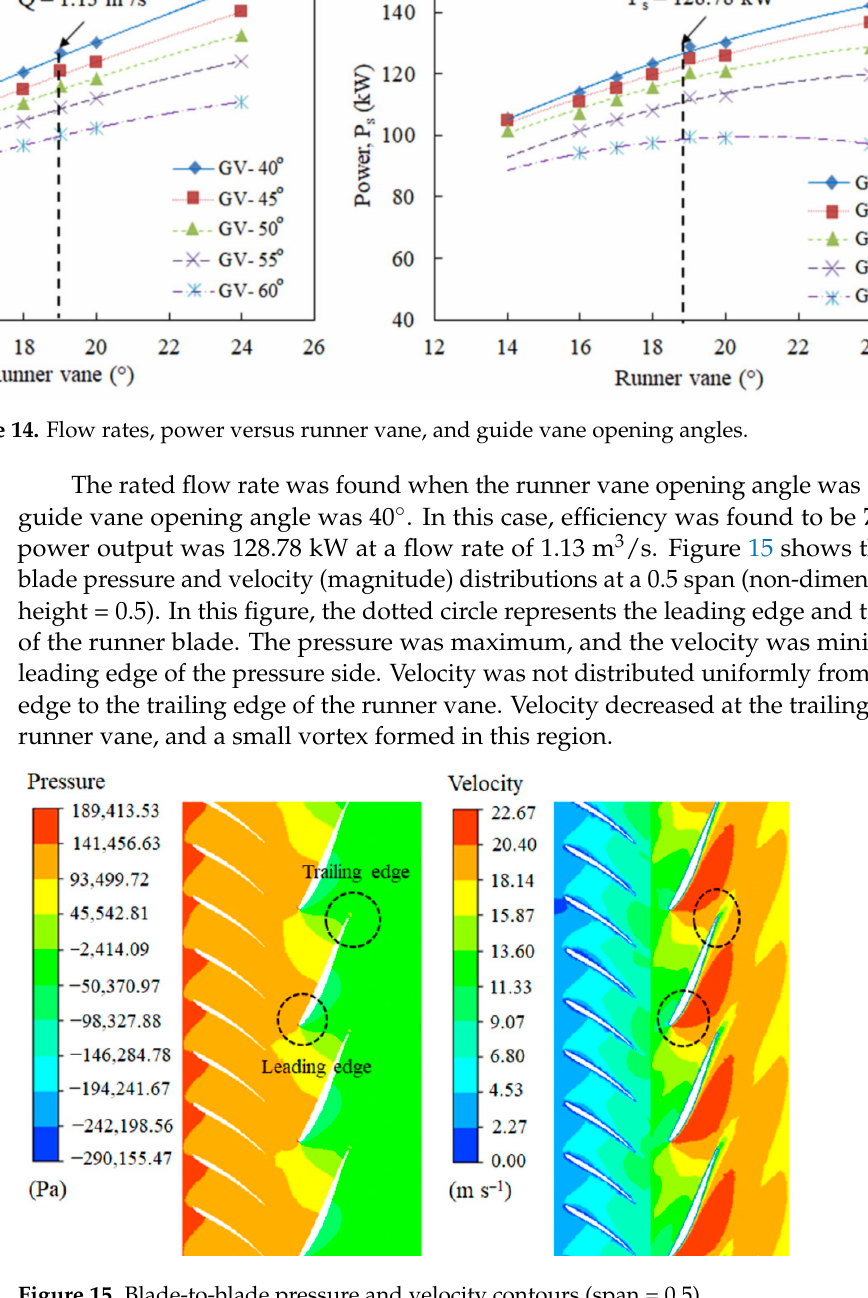
Commented [M5]: Please change ms -1 to m s − 1 , there is space between m and s. The hyphen (-) should be minus ( − )